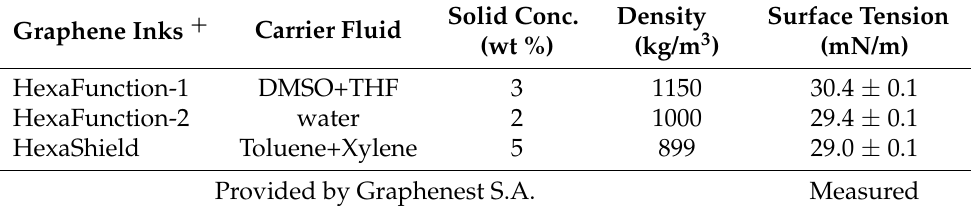
Table 1. Main properties of the commercial graphene inks considered in this study. Solid Conc. Density Surface Graphene Inks + Carrier Fluid